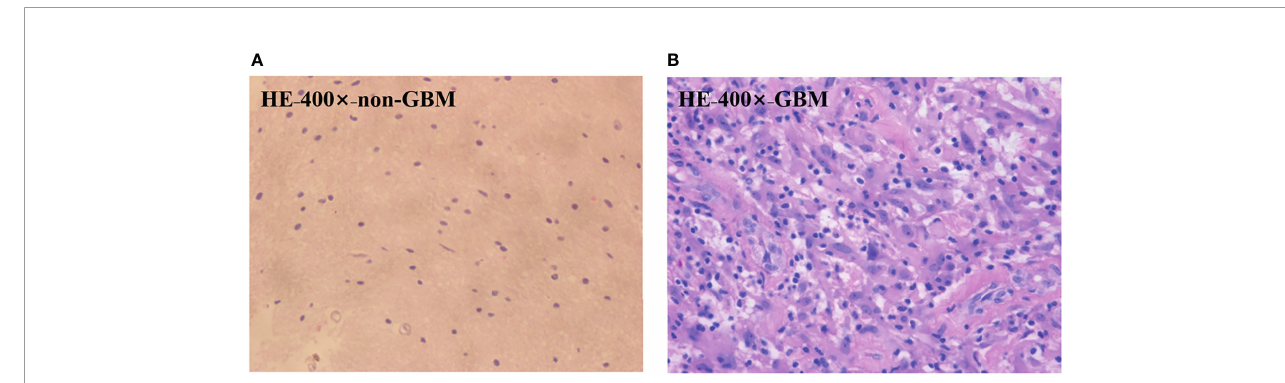
FIGURE 3 | HE-stained 6- m m-thick slice of the GBM (A) region and the non-GBM (B) region from the same region of PIT images.